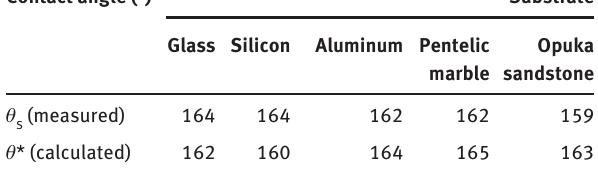
Table 3 Contact angles θ * calculated using the Cassie-Baxter equa- tion, Eq. (5), and static contact angles, θ , measured experimentally S (reproduced from Figure 12) for superhydrophobic siloxane-nano- particle films deposited on five substrates